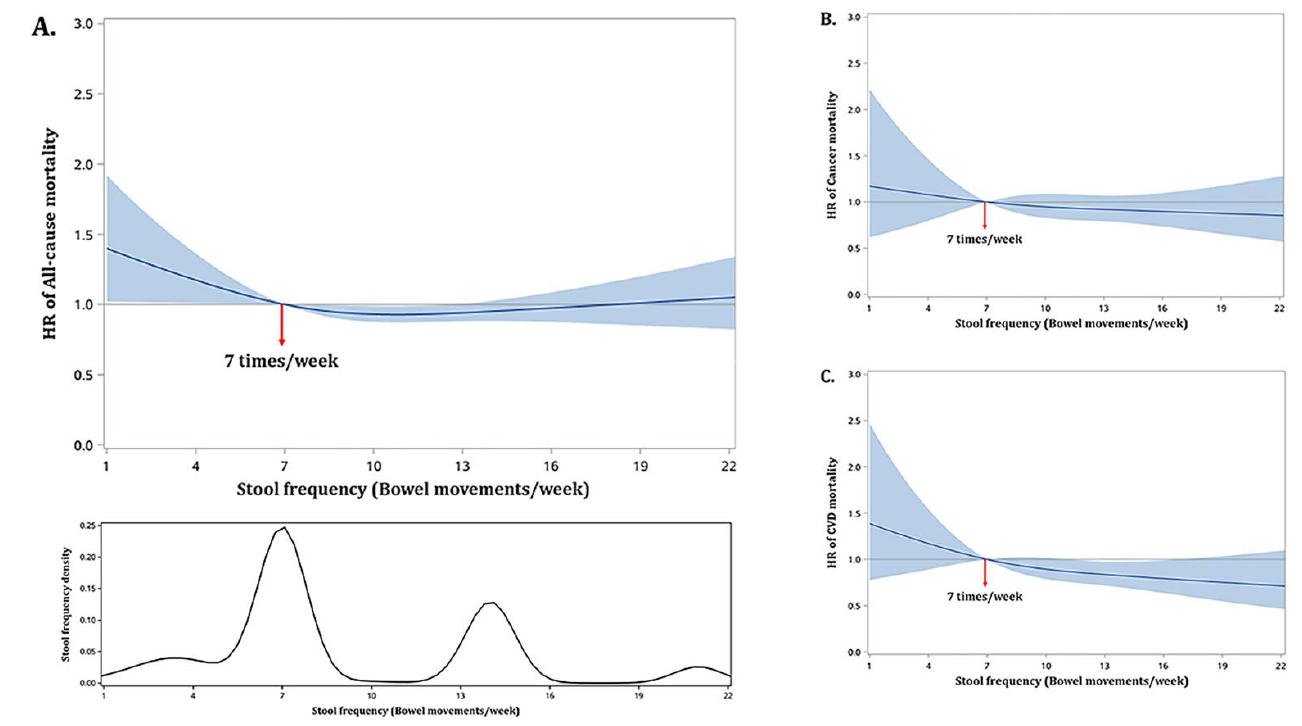
Figure 2. Non-linear relationship between stool frequency and all-cause ( A ), cancer- ( B ), and CVD- specific mortality ( C ) in U.S. adults (NHANES 2005 – 2010). The non-linear relationship is depicted by using a restricted cubic spline with 3 knots at stool frequencies of 4, 7 (reference), and 14 times/week of bowel movements. The solid curves represent HRs estimated by using weighted Cox regression models adjusting for age, sex, race/ethnicity, family income, BMI, smoking status, alcohol consumptions, physical activities, dietary fiber intake, and history of chronic diseases. The shaded area represents the 95% confidence intervals of the HRs.